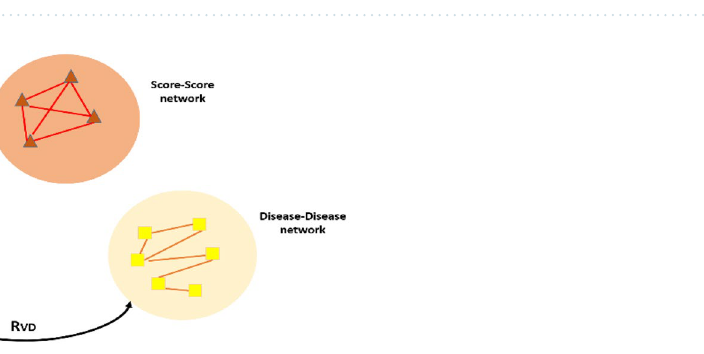
Figure 1. Schematic of two-source algorithm. It shows the training and testing part of the algorithm. The figure is created using Microsoft PowerPoint 2013.